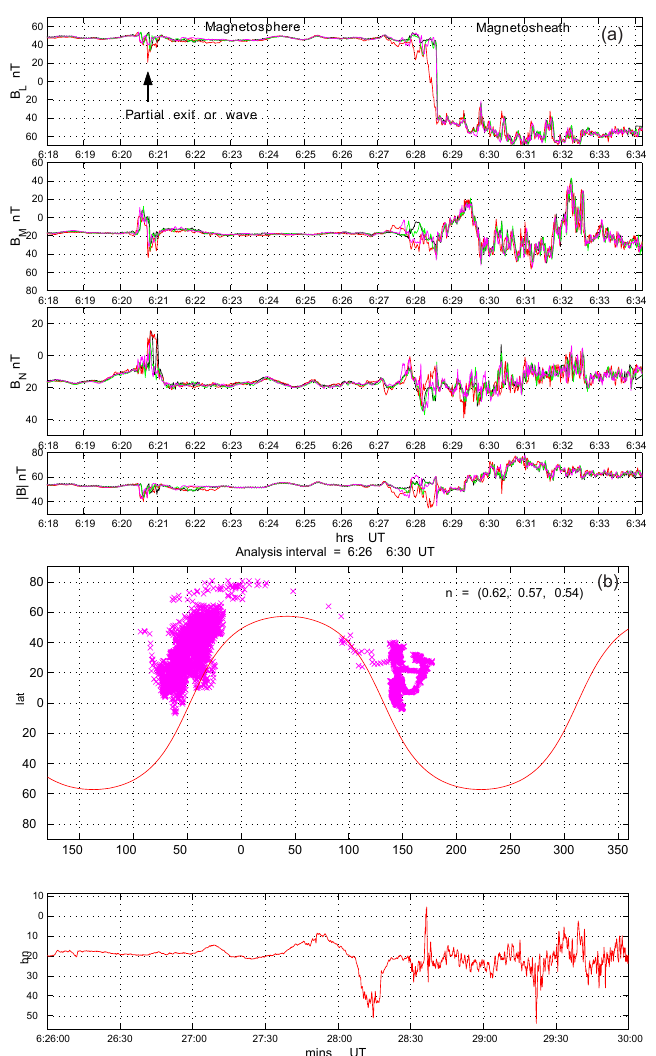
Fig. 5. (a) As for Fig. 4a, but for crossing 2. (b) As for Fig. 4b, but for crossing 2. The planar fit to the scatter plot is not shown.